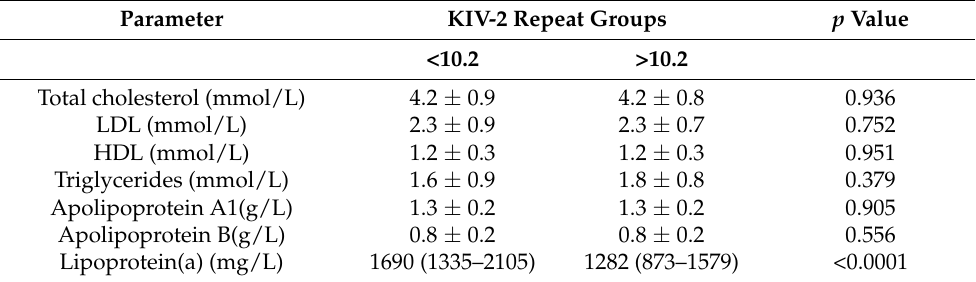
Figure 2. Correlation of Lp(a) levels and IMT with KIV2 repeats. Pearson correlation analysis was performed to determine the correlation of KIV2 repeats with Lp(a) levels ( a ) and IMT ( b ), respectively. **** p < 0.0001. Table 4. Lipids in the KIV-2 repeats groups.